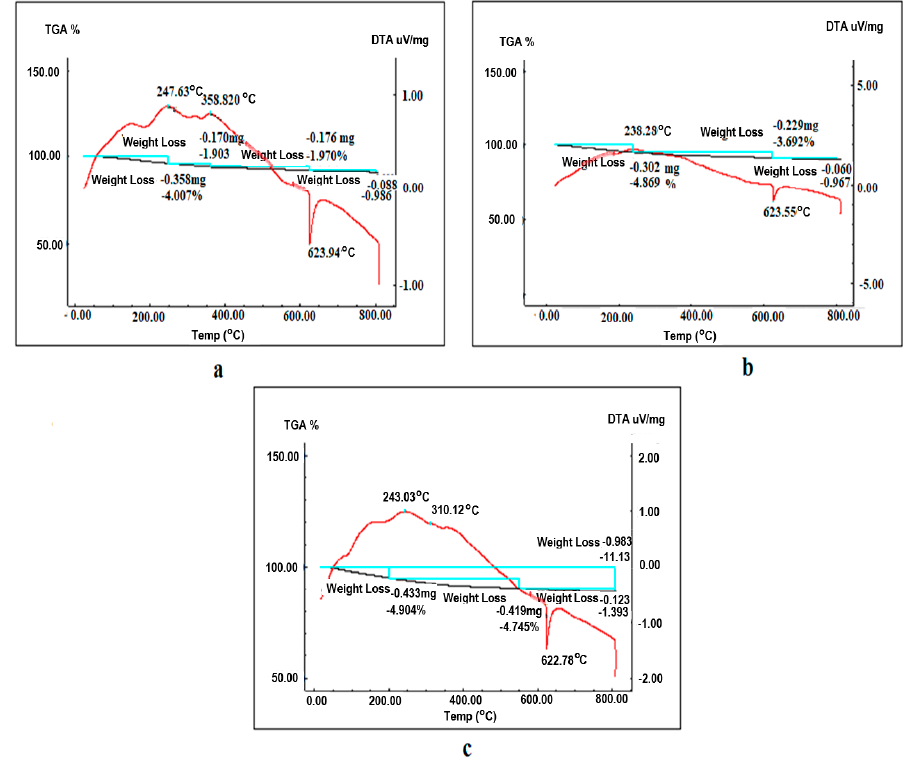
Figure 6. The derivatograms of zeolites. Zeolites: ( a ) natural; with the maximum content of cations: ( b ) In 3+ ; ( c ) with a minimum content of the In 3+ cations.